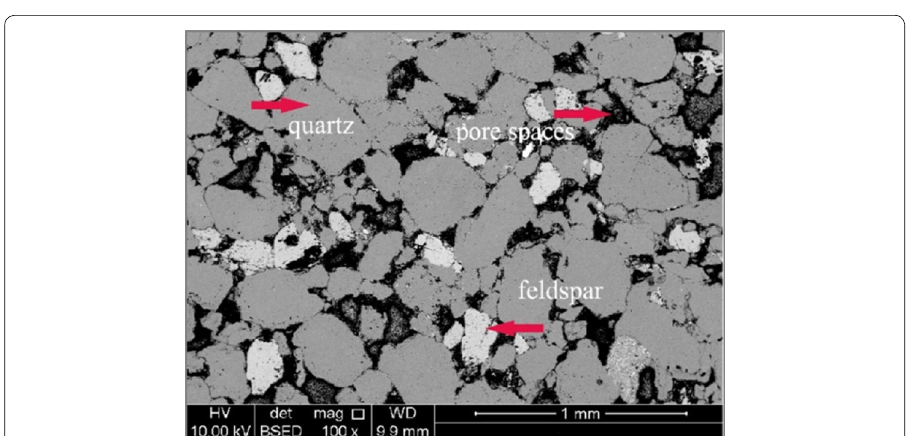
Fig. 7 Texture of the original sandstone of the stratigraphic unit Bausandstein–Geröllsandstein (BSE image, SEM;